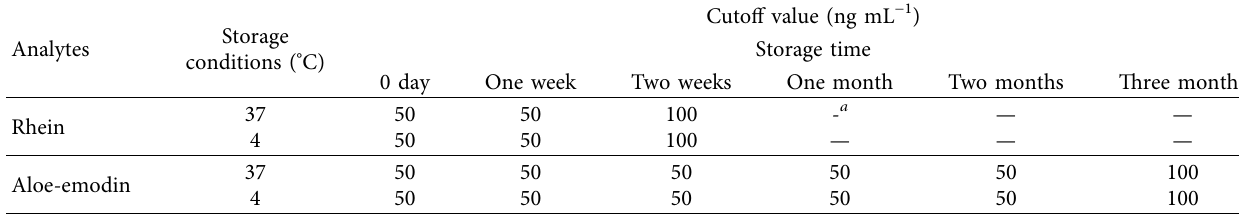
Table 3: The storage stability of CGIC